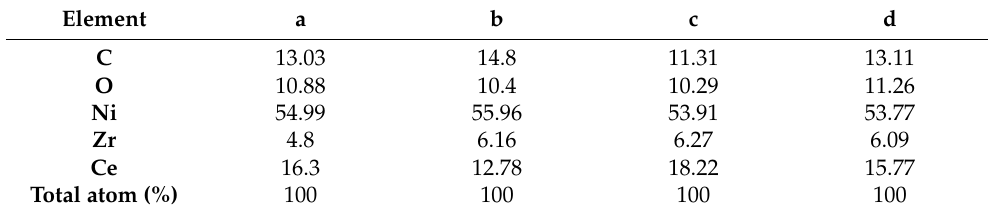
Figure 10. Composition of catalysts from EDS mapping. Table 3. Composition of catalysts from EDS Point.